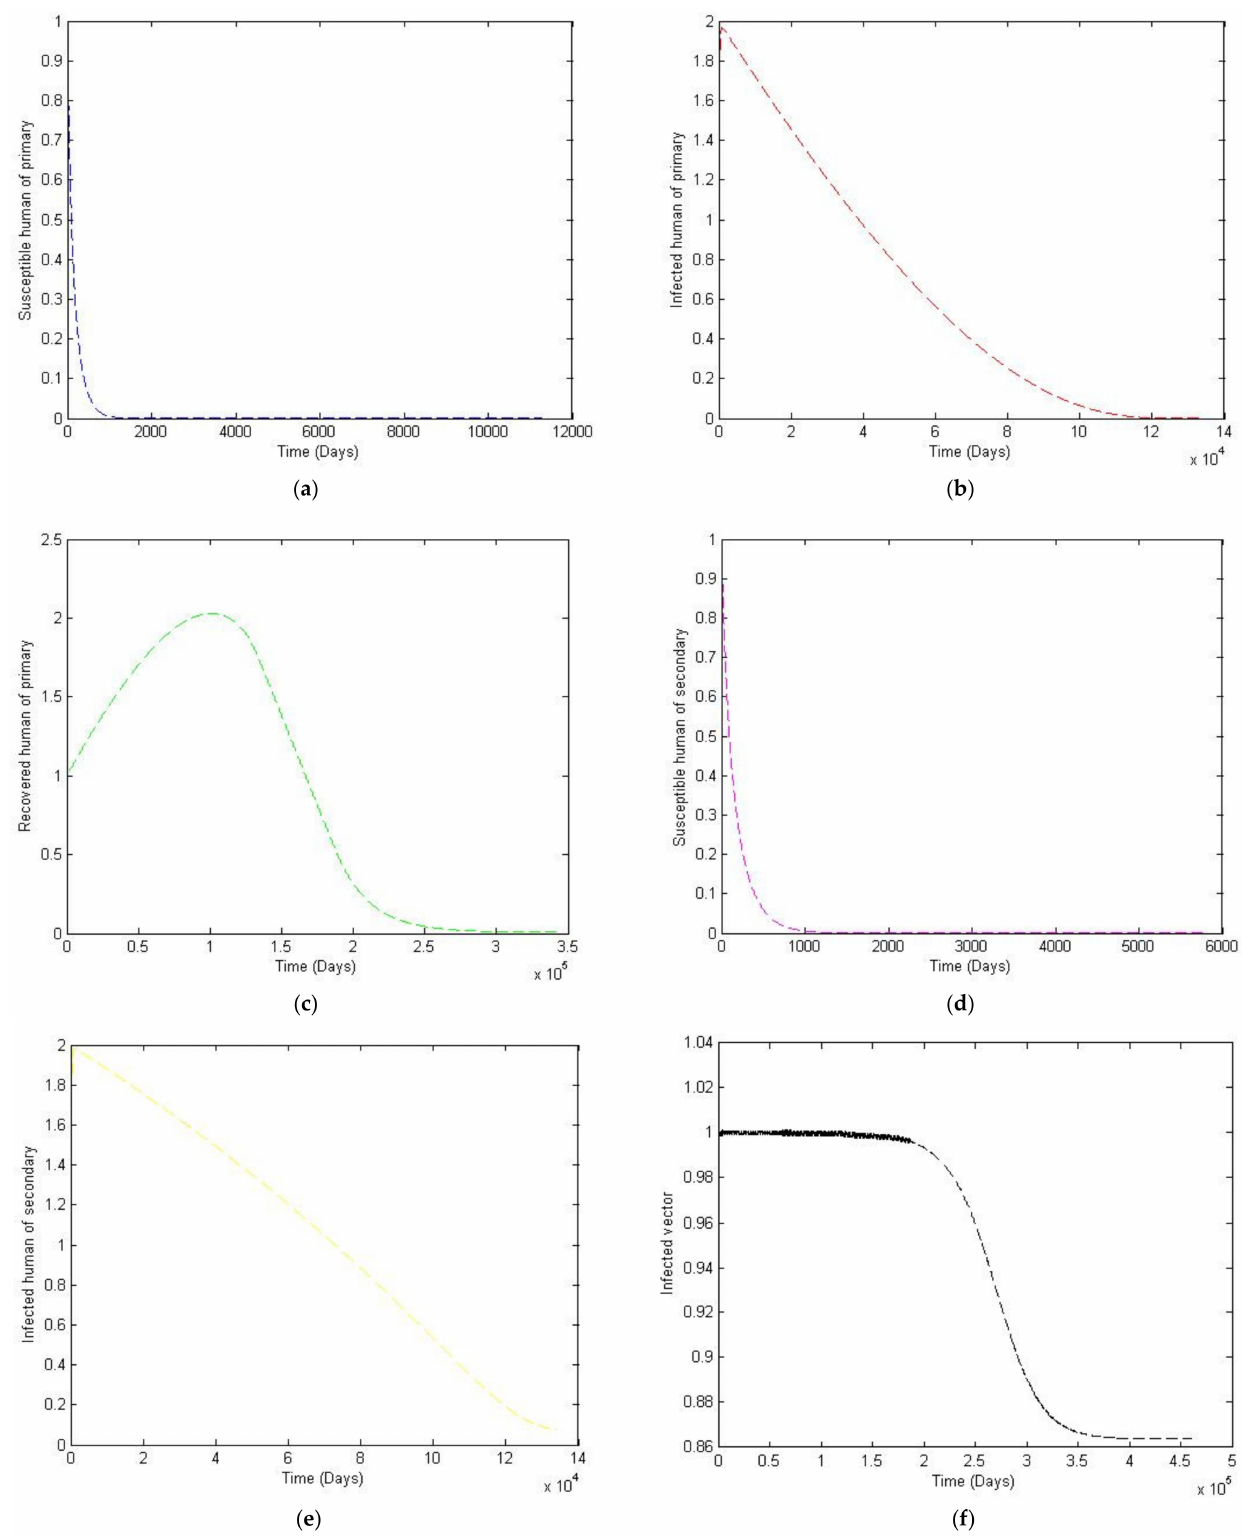
Figure 8. The trajectory of S HP , I HP , R HP , S HS , I HS and I V toward the endemic equilibrium point for R 0 > 1 with parameter values according to Table 3; changes N H = 500,000, and N V = 100,000 e ( − 1/14 ) t . ( a ) Susceptibles of primary infection ( b ) Infected population with primary infection ( c ) Recovered human of primary infection ( d ) Susceptibles of secondary infection ( e ) Infected human of secondary infection ( f ) Infected